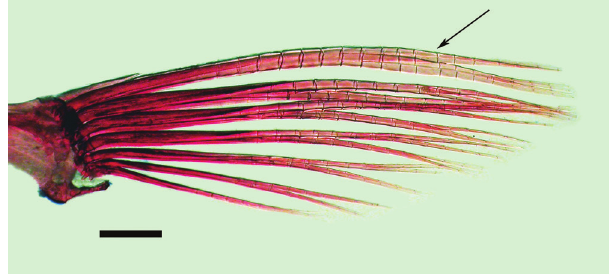
Table 1. Morphometric data of holotype (H, MCP 30000)